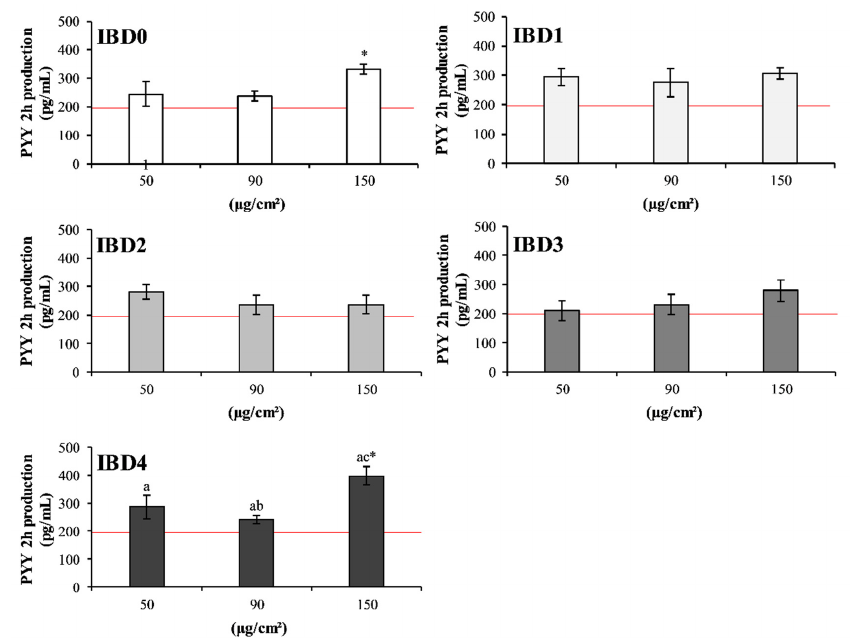
Figure 3. Differential secretion of PYY by intestinal co-culture after incubation with IBDs. The graphs with 50, 90, and 150 µg/cm 2 of IBD0, IBD1, IBD2, IBD3, and IBD4. Asterisks highlight statistically significant di ff erence vs. CTR cells (red line, p < 0.05), while letters vs. di ff erent concentrations of the same IBD ( p < 0.05). Each value comes from one independent experiment with two